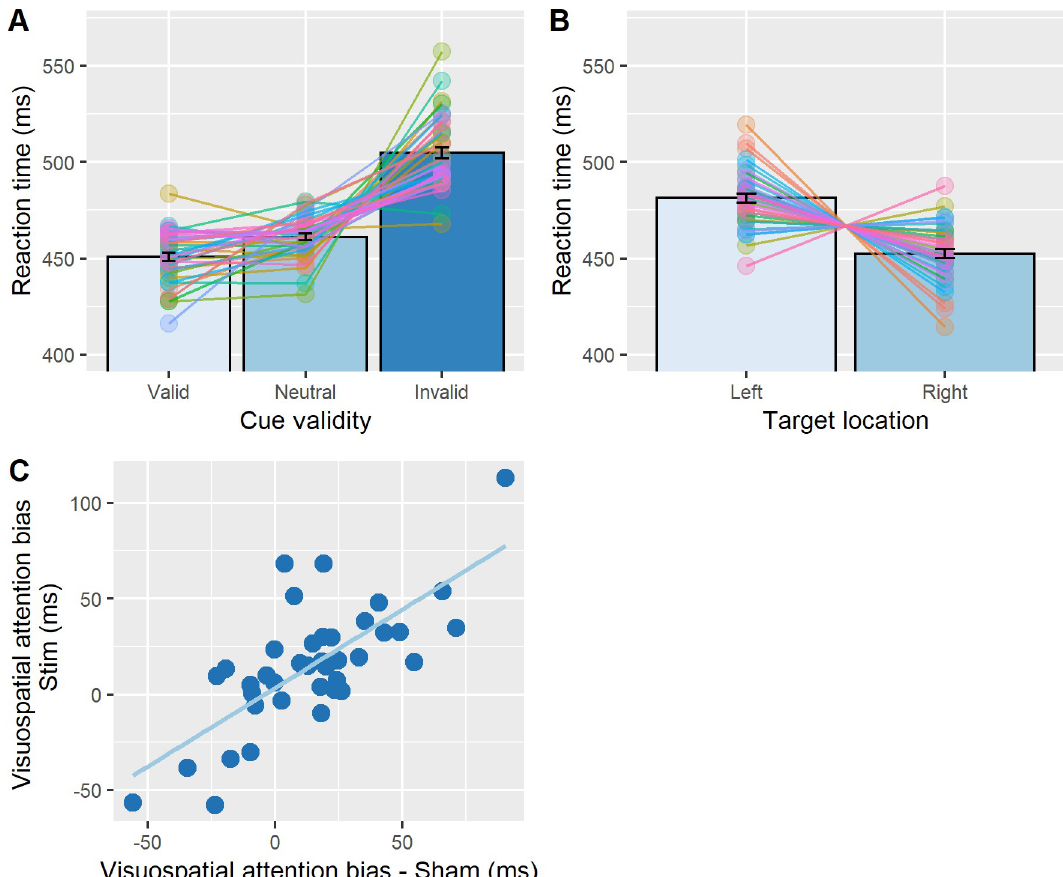
Fig 2. Experimental checks. A. Cueing effect: RTs were averaged across target location for each type of cue (sham session only). Significantly faster RTs were found for valid trials, as compared to neutral and invalid trials. RT in neutral trials were significantly faster than invalid trials. Error bars represent 95% confidence interval corrected for a within subjects design [46]. The bar plots have been superimposed with individual data points. B. Hemifield bias: RTs were averaged across cue validity conditions for each target location (sham session only). Significantly faster RTs were found for trials in which the stimuli were presented in the right hemifield, as compared to the left. Error bars represent 95% confidence interval corrected for a within subjects design [46]. Similarly, the bar plots have been superimposed with individual data points. C. Correlation of measure of hemifield bias between the two experimental sessions . Since the intercept is close to 0 (i.e. 3.3 ms) and the slope is close to 1 (i.e. 0.8), the model already indicates that the spatial bias in the two experimental sessions (RT Left hemifield − RT Right hemifield ) is very similar and therefore a significant effect of stimulation is unlikely. We then tested whether there was a difference between the RTs in the left as compared to the right hemifield in the sham condition (RT left > right visual field), as reported by Schuh- mann et al. [36] employing the same paradigm. A t-test on median RTs (data averaged across cue validity, Fig 2B) indeed revealed a significant difference between hemifields (t(39) = 3.13, p = .003, r 2 = .24). Participants responded significantly faster when stimuli were presented in the right visual field (459.6 ± 81.3ms) than the left visual field (474 ± 75.4ms), replicating Schuh- mann et al. [36]. This result suggests that on average, participants had a rightward bias overall. Before testing the main hypothesis that left parietal alpha-tACS but not sham affects this rightward bias, we wanted to check how consistent this measure of bias was within partici- pants. To this end, a Pearson’s product-moment correlation coefficient was calculated for the bias measures obtained in each session. There was a significant positive correlation between